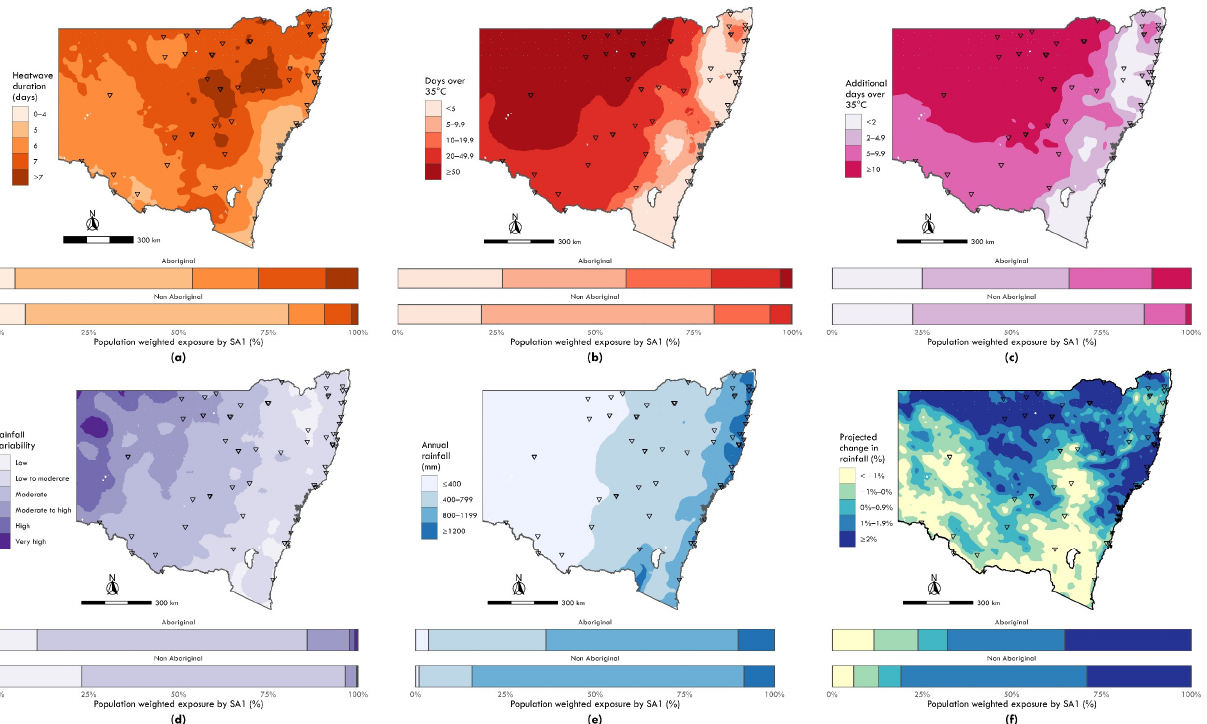
Figure 2. Maps of climate exposures with bar charts indicating relative exposure by category across